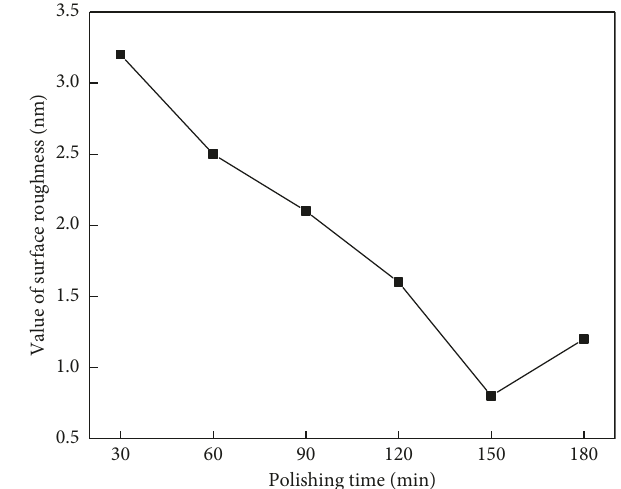
Figure 3: The relationship between the surface roughness and the type of polishing